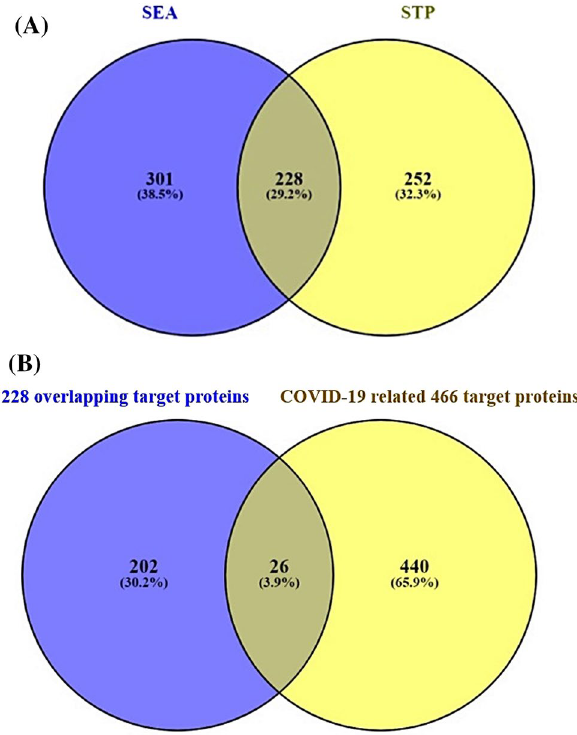
Figure 3. ( A ) Overlapping target proteins (228 target proteins) of NSAIDs related target proteins identified from SEA (529 target proteins) and STP (480 target proteins). ( B ) Overlapping target proteins (26 target proteins) between NSAIDs related 228 overlapped target proteins and COVID-19 related 466 target